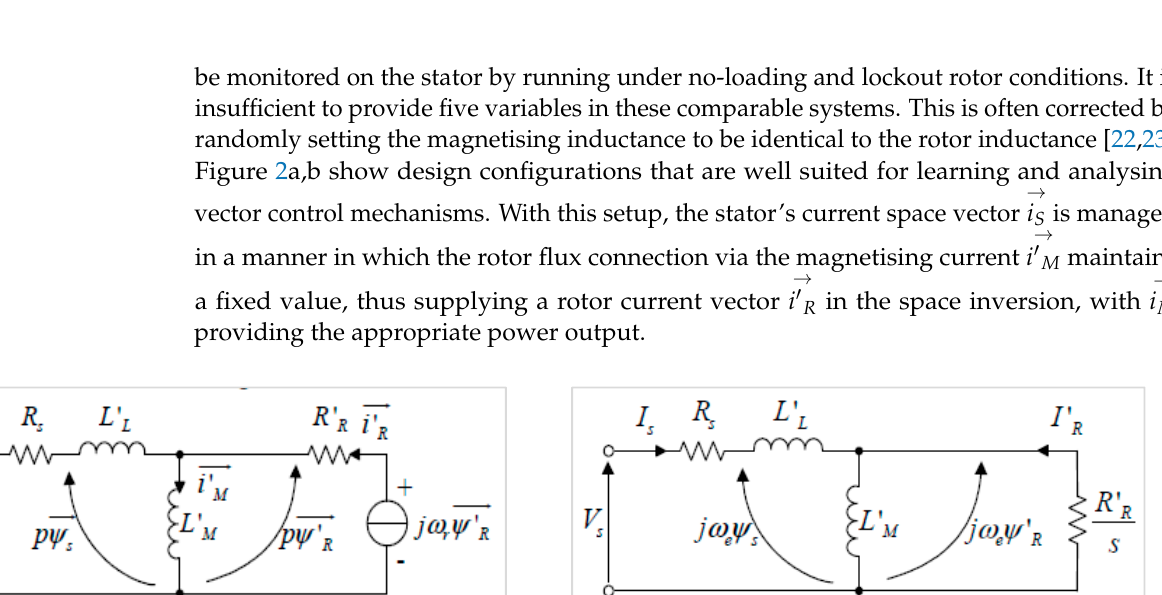
Figure 4. Loss model of an induction motor [27]. 5.4. Simplified Model Many stable algorithms contain an adaptable induction machine simulation that is derived from either or both of the equivalent topologies shown. A single-cage induction machine offers modest start-up torque multiplication. With that, the single-cage design is frequently inaccurate. Such issues can be addressed by employing a dual-cage or deeper bar rotor design. A shortage of data frequently limits the usage of dual-cage and deeper bar designs. Improving the torque-slip property of a single-cage design is a streamlined remedy for these instances. The rotor resistance is often changed with slip, which is simple to accomplish during each convergence phase of the model. An adaptable design simula- tion that relies on the equivalent circuits illustrated in [27] is often utilised for transient reliability research [27–29]. 5.5. Simplified d–q Design The steady-state equivalent diagram depicted in [29] serves as the foundation for the concept of the induction machine. The simplified model presented in [29] is utilised for the dynamic simulation diagram. The d–q model of this analysis was regarded as pre- cisely acceptable for acting as a baseline design and was subsequently utilised to assess the adequacy of different designs when implemented for voltage balance analyses [30]. The variables of the designs are depicted in [29]. 6. Proposed Design Figure 5 presents the proposed modelling technique for an induction motor; the three-phase supply voltage is supplied to the machine, and then the voltages are trans- formed using the 0dq axis to produce the vectors 𝑉 (cid:3044) and 𝑉 (cid:3031) . Hence, the stator currents and voltages are produced; subsequently, the rotor parameters are also considered. The im- plementation is outlined in this paper.